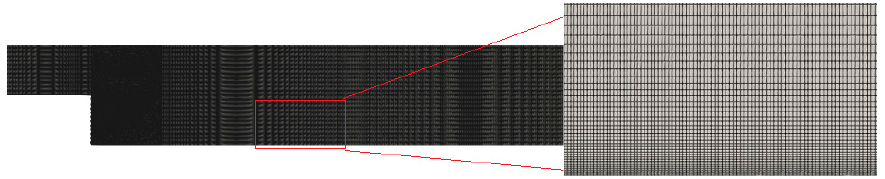
Figure 3. General view of the grid and zoom of the grid near the bottom wall.